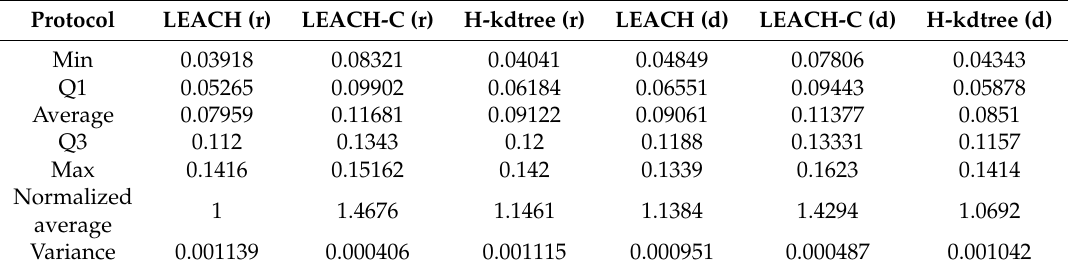
Table 4. Average energy of each node with 200 nodes. (r) random—(d) deterministic.